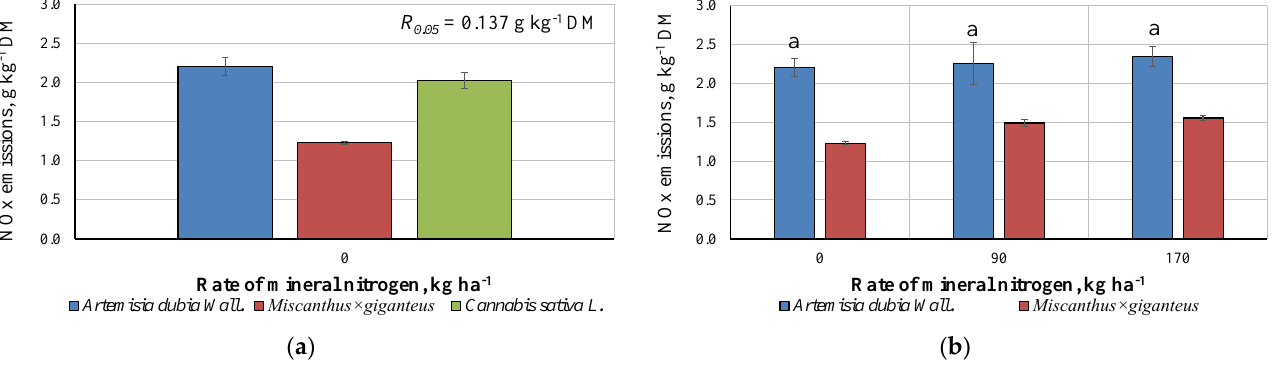
Figure 9. The dependence of NOx emissions of Artemisia dubia Wall., Miscanthus × giganteus and Cannabis sativa L. not fertilized ( a ), on mineral nitrogen fertilization ( b ) ( R 0.05 ( A. dubia ) = 0.281 g kg − 1 DM, R 0.05 ( M. giganteus ) = 0.053 g kg − 1 DM, R 0.05 ( A. dubia × M. giganteus ) = 0.160 g kg − 1 DM. a, there are no statistically significant differences ( p < 0.05) between the columns marked with the same letter, as assessed using the least significant difference.